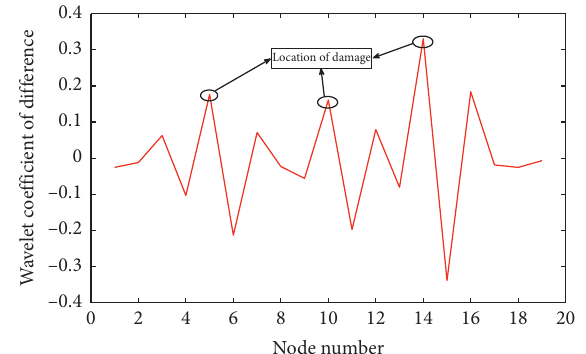
Figure 22: Wavelet coefficient difference for 20% damage in section